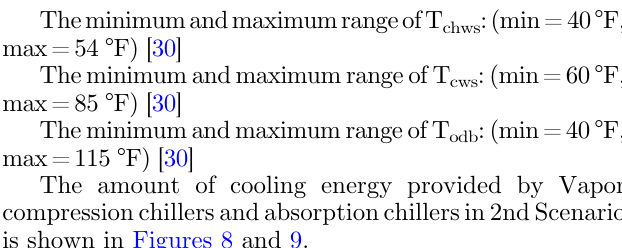
Fig. 7. The amount of cooling load provided by absorption chillers (scenario